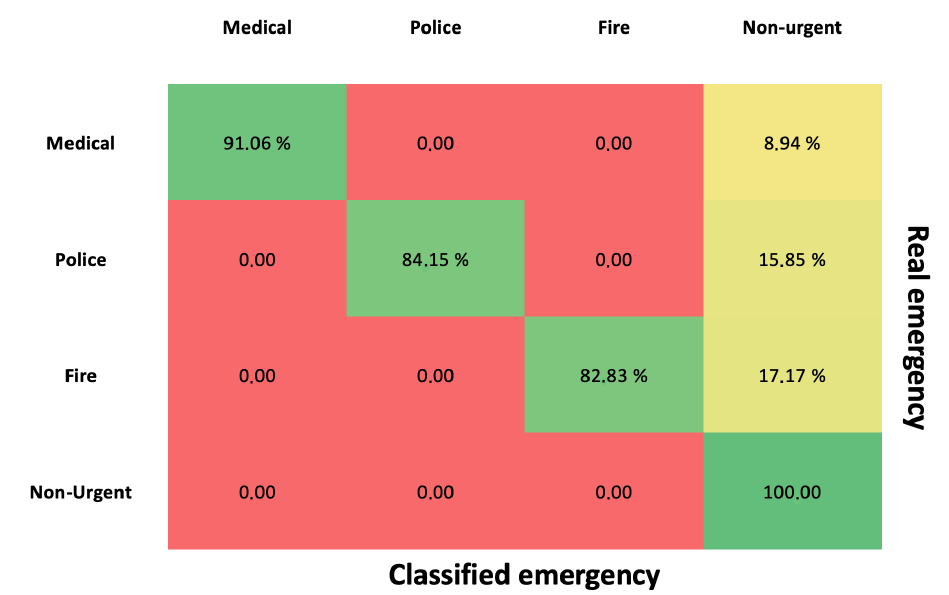
Figure 11. Decision tree evaluation for the empirical laboratory experiments.